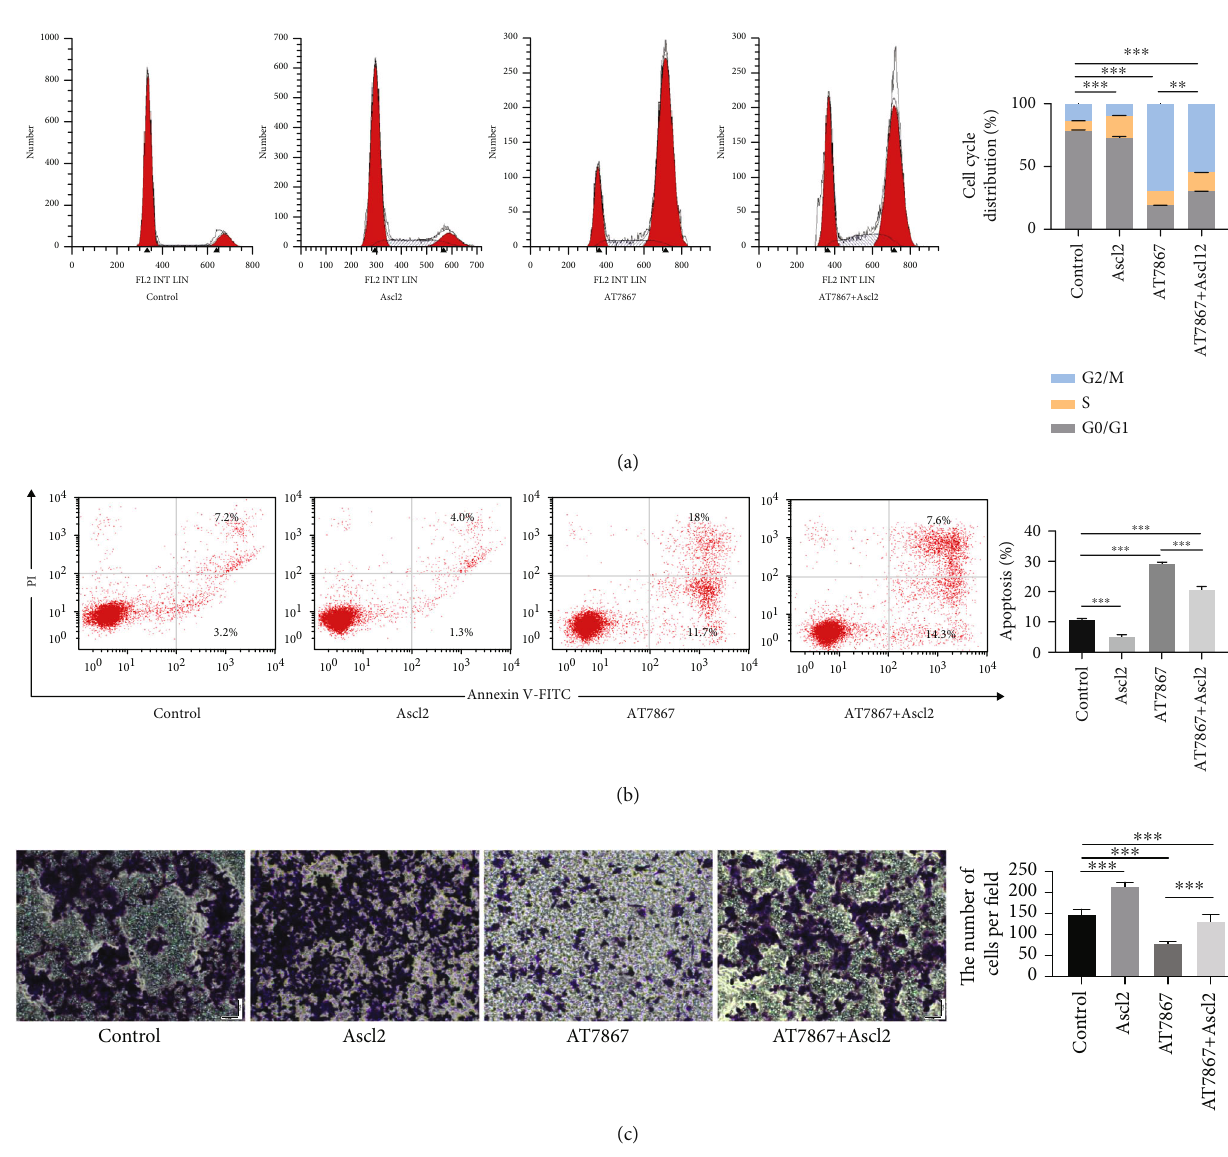
Figure 7: AT7867 regulates CSC proliferation by inhibiting Ascl2. (a, b) The cell cycle distribution and cell apoptosis were detected by fl ow cytometry. (c) Transwell assay was performed to detect invasive assay. ∗ P < 0 : 05 , ∗∗ P < 0 : 01 , and ∗∗∗ P < 0 : 001